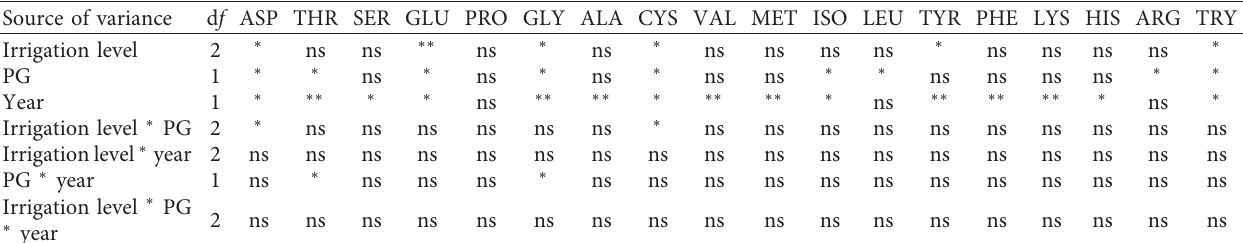
Table 3: Significance of the main effects of irrigation regimes, year, and PG and their interactions on seed composition traits at Stoneville, MS, during 2018-2019 crop seasons. Source of